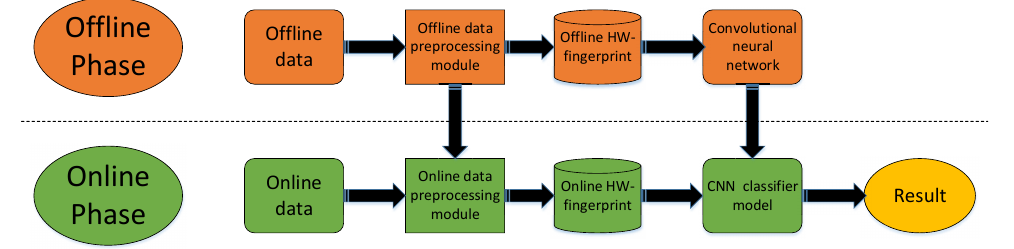
Figure 1. Proposed system